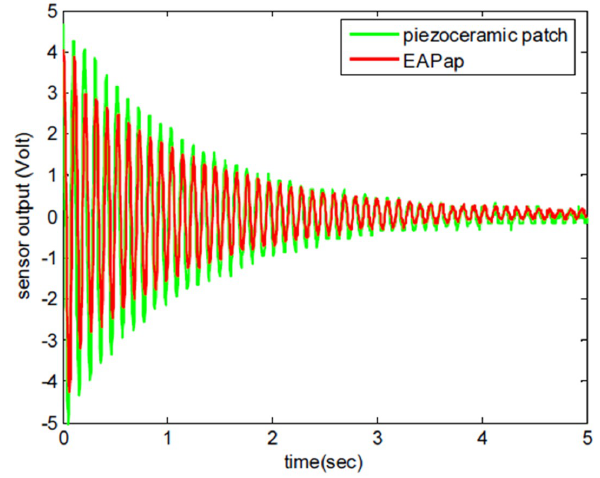
Figure 4. Impulsive response of the beam measured by EAPap and piezoceramic patch [29]. Lee et al. [36] studied the direct piezoelectricity of EAPap by subjecting the EAPap to in‐plane